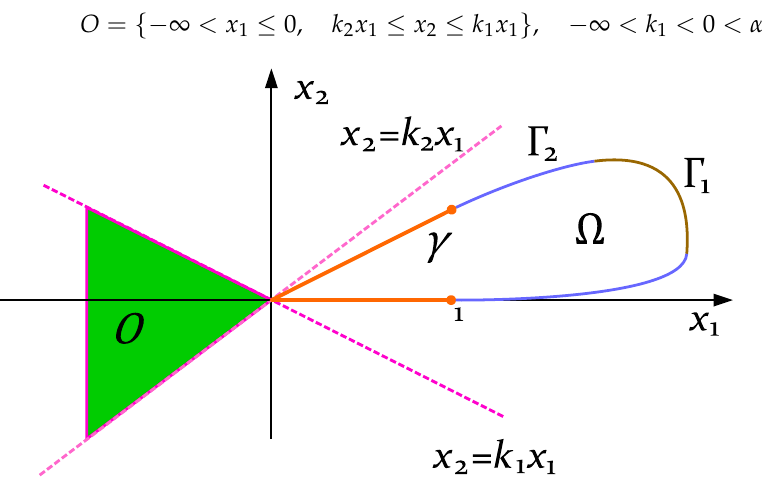
Figure 1. Geometry of the problem for composite body with the thin rigid